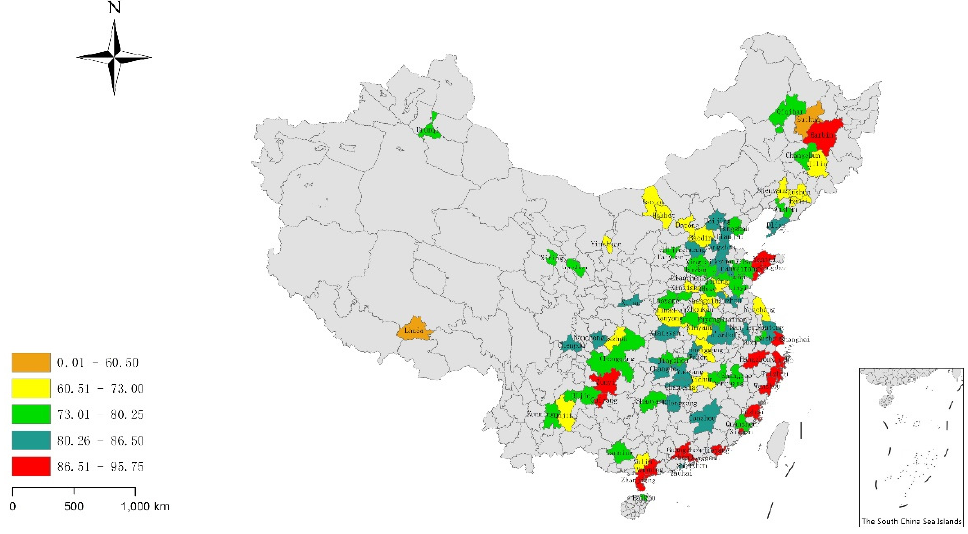
Figure 2. The distribution of law-based governance